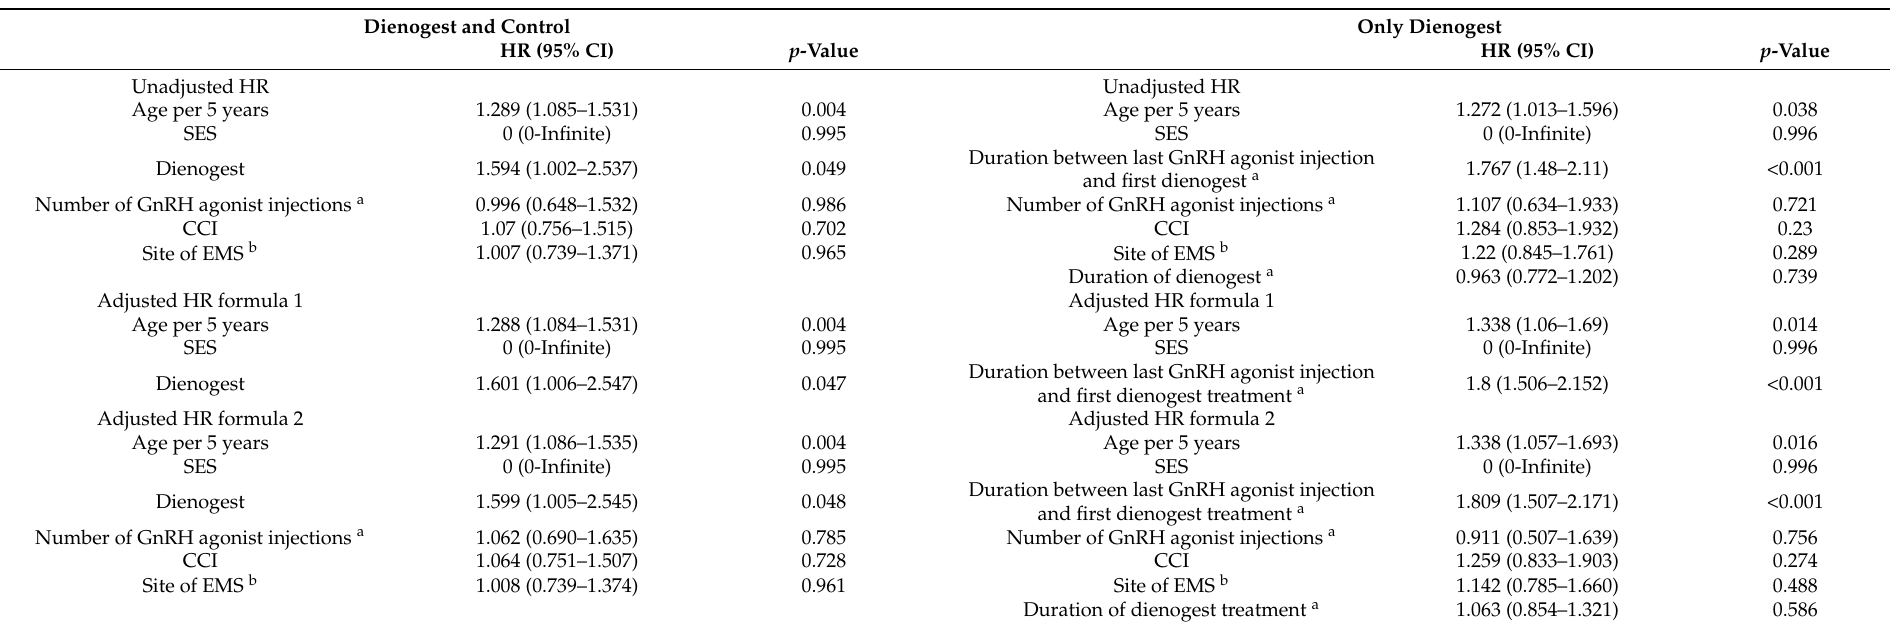
Table 3. Cox proportional hazard model for reoperation according to dienogest start time in the HIRA 2013–2018 data. Dienogest and